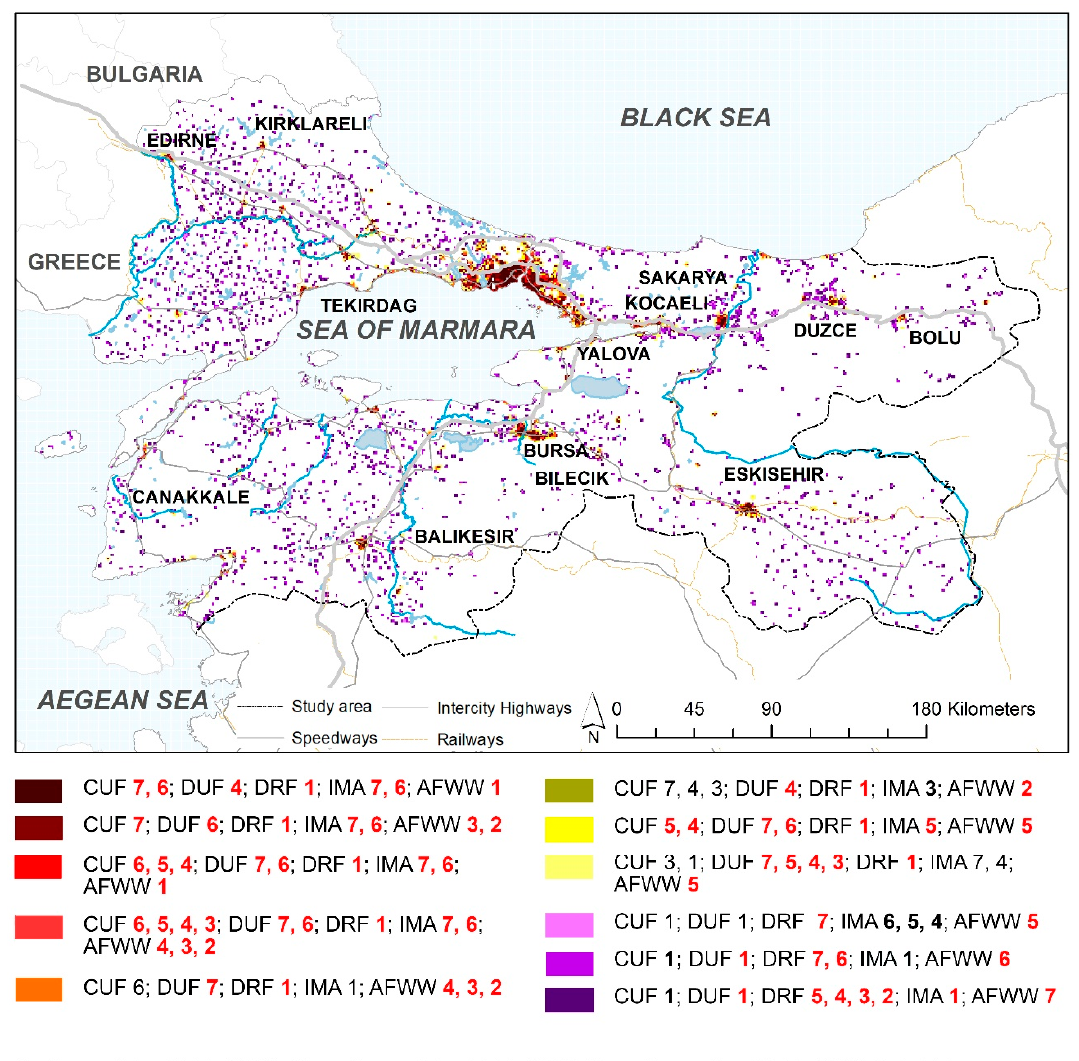
Figure 10. Urban fabric land cover composition in 2018.